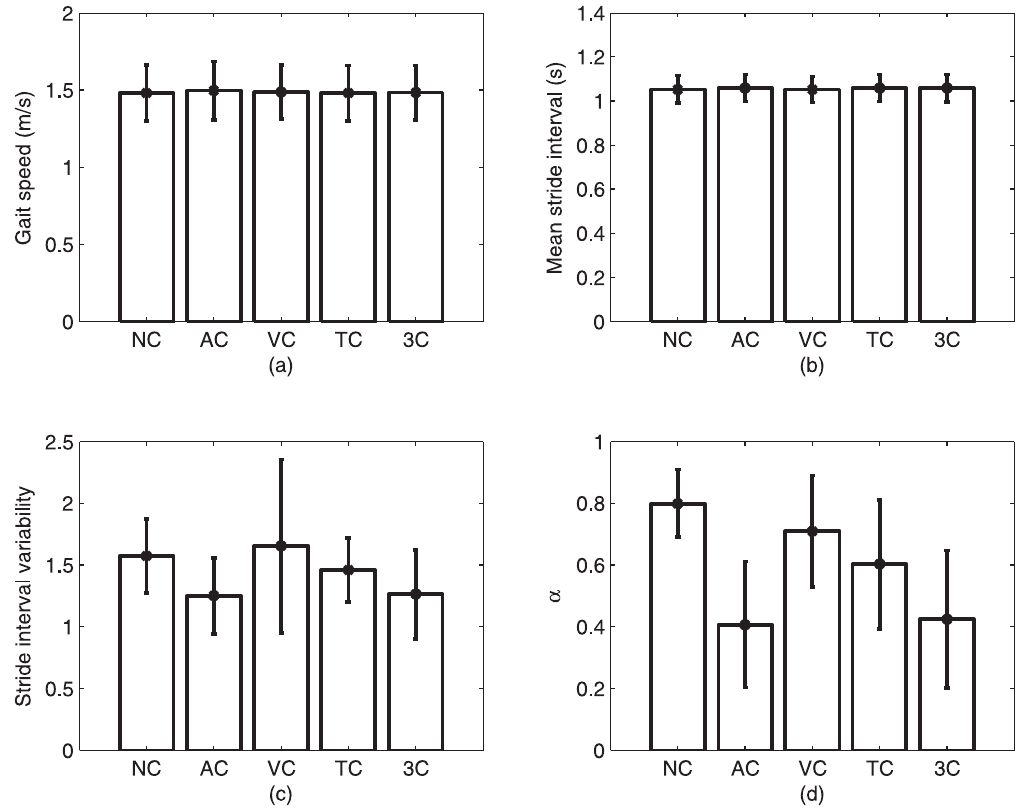
Figure 1. Gait dynamics of participants during the five walking conditions (NC = no cue; AC = auditory cue; VC = visual cue; TC = tactile cue; 3C = three cues). (a) gait speed; (b) mean stride intervals; (c) stride interval variability; and (d) scaling exponents. Error bars denote standard deviation in each case.